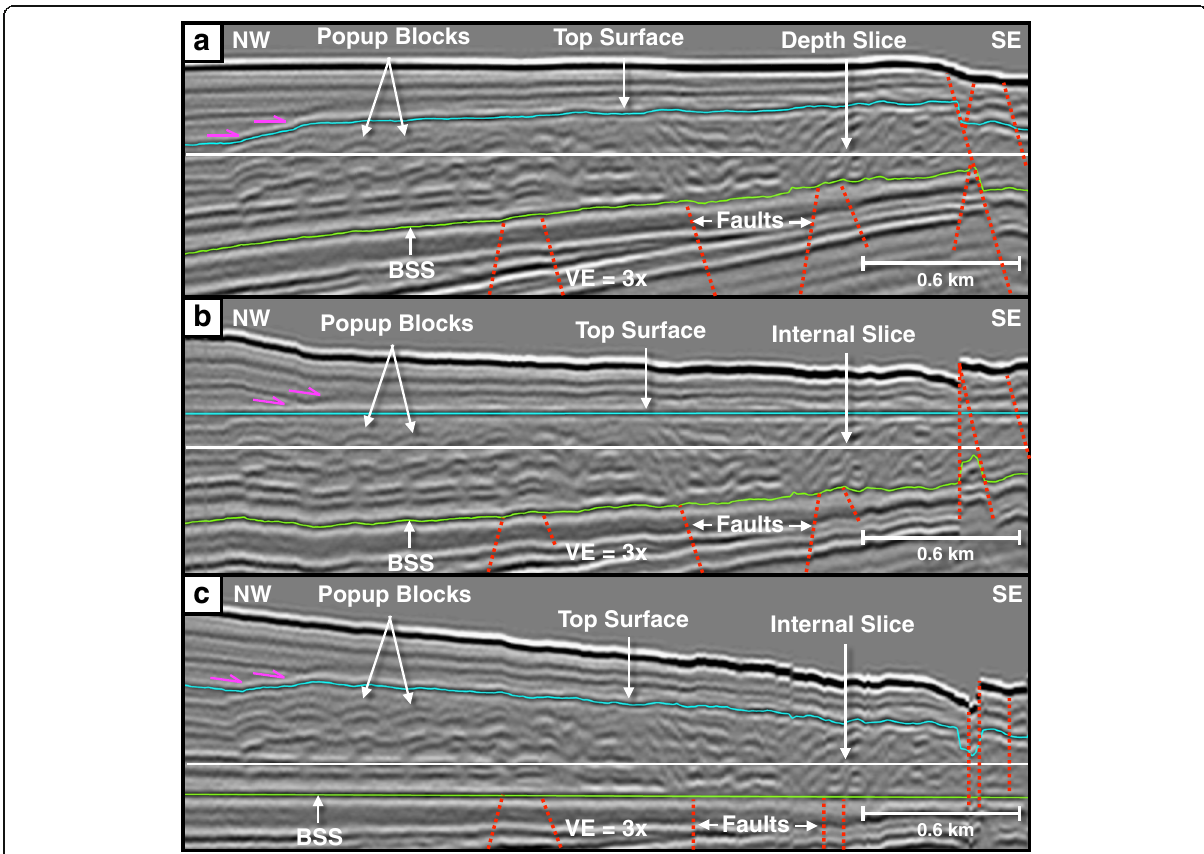
Fig. 8 Structural flattening of interpreted horizons, see Fig. 11a for arbitrary line location. The primary direction of translation is SE ➔ NW. BSS — basal shear surface. Purple arrows indicate onlapping relationships. a Arbitrary seismic line of MTD 4 toe domain. Note how the depth slice (white line) intersects the pop-up blocks at various stratigraphic levels. b Structurally flattened top surface. Note how the flattened image permits an internal slice (white line) to cross the top surface of each pop-up block. c Structurally flattened BSS. Note how the flattened image permits an internal slice (white line) to cross the pop-up blocks at the same stratigraphic level near the